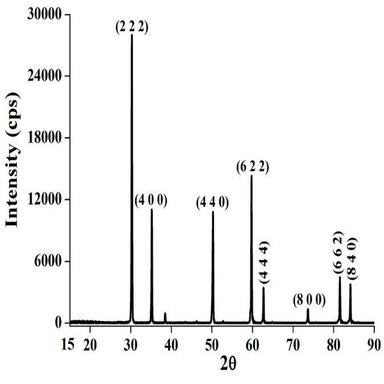
XRD pattern of Yb1.98Lu0.02Sn2O7.